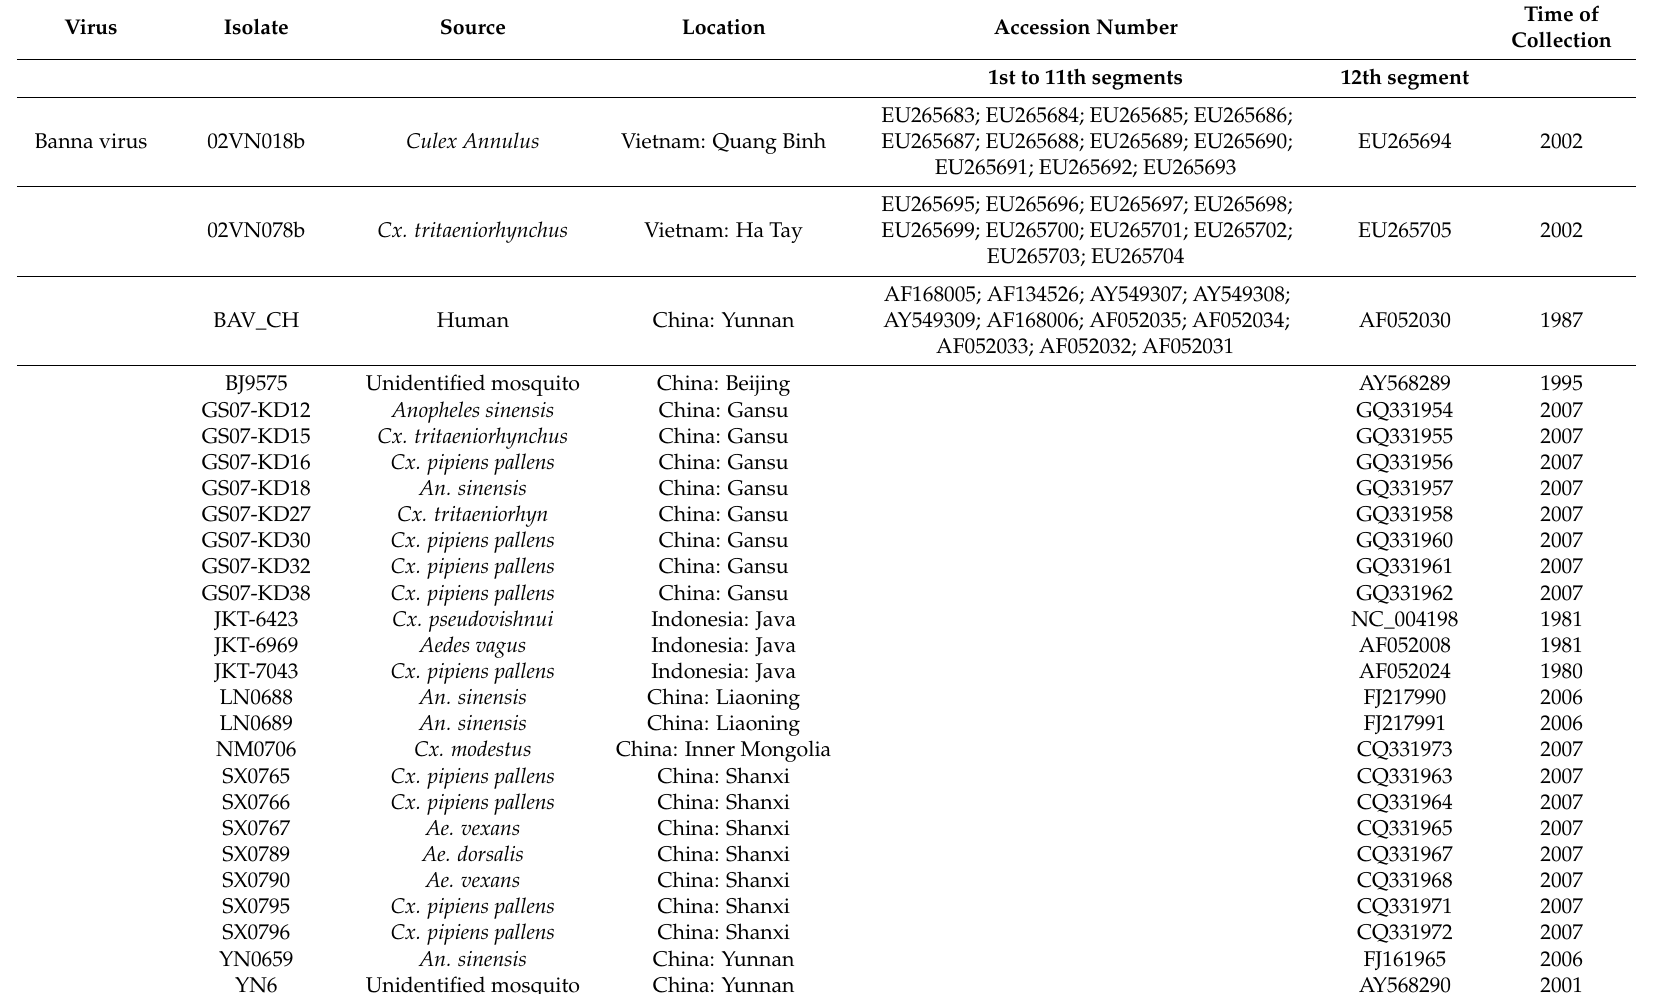
Table 1. Background information for viruses used in the